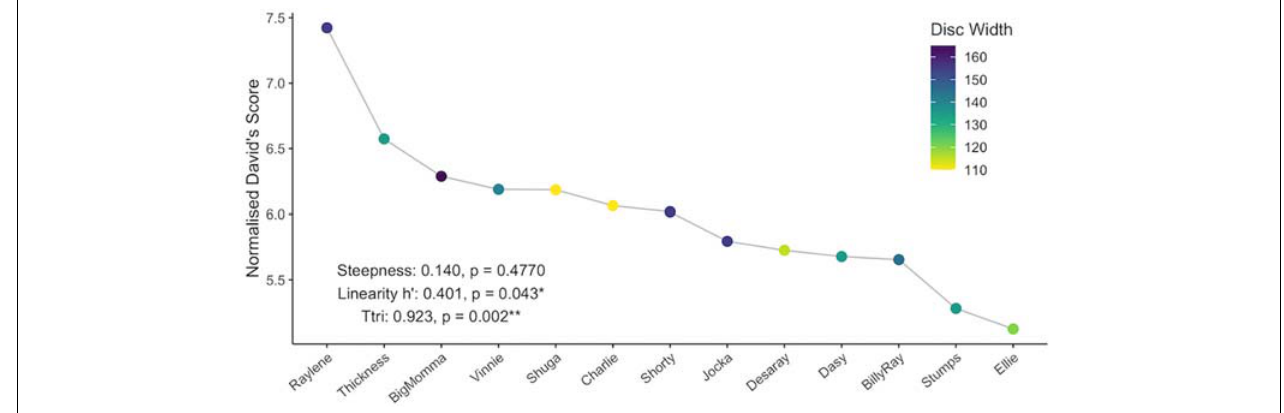
FIGURE 3 | Individual normalized David’s scores and associated steepness, linearity, and triangle transitivity (Ttri) of the dominance hierarchy. Nodes are colored by disc width